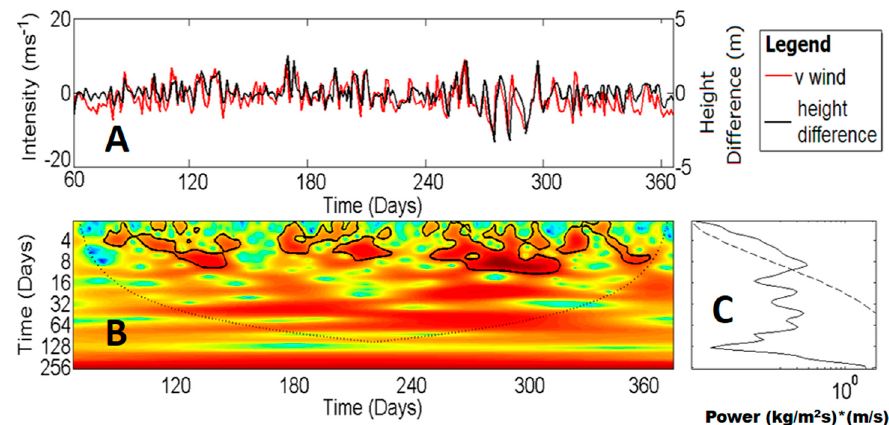
Figure 8. ( A ) Temporal variability of simulated height di ff erence between the Patos lagoon extremities (black line) and measured longitudinal component of the wind (red line) used for the cross-wavelet analysis. ( B ) Local cross energy spectrum based on a Morlet wavelet analysis. The black thick contours indicate a 95% confidence limit for a red noise process with a lag-1 of α = 0.72, and the black dotted line indicates the influence cone of edge e ff ects. ( C ) Global cross energy spectrum. The black dashed line indicates the 95% confidence